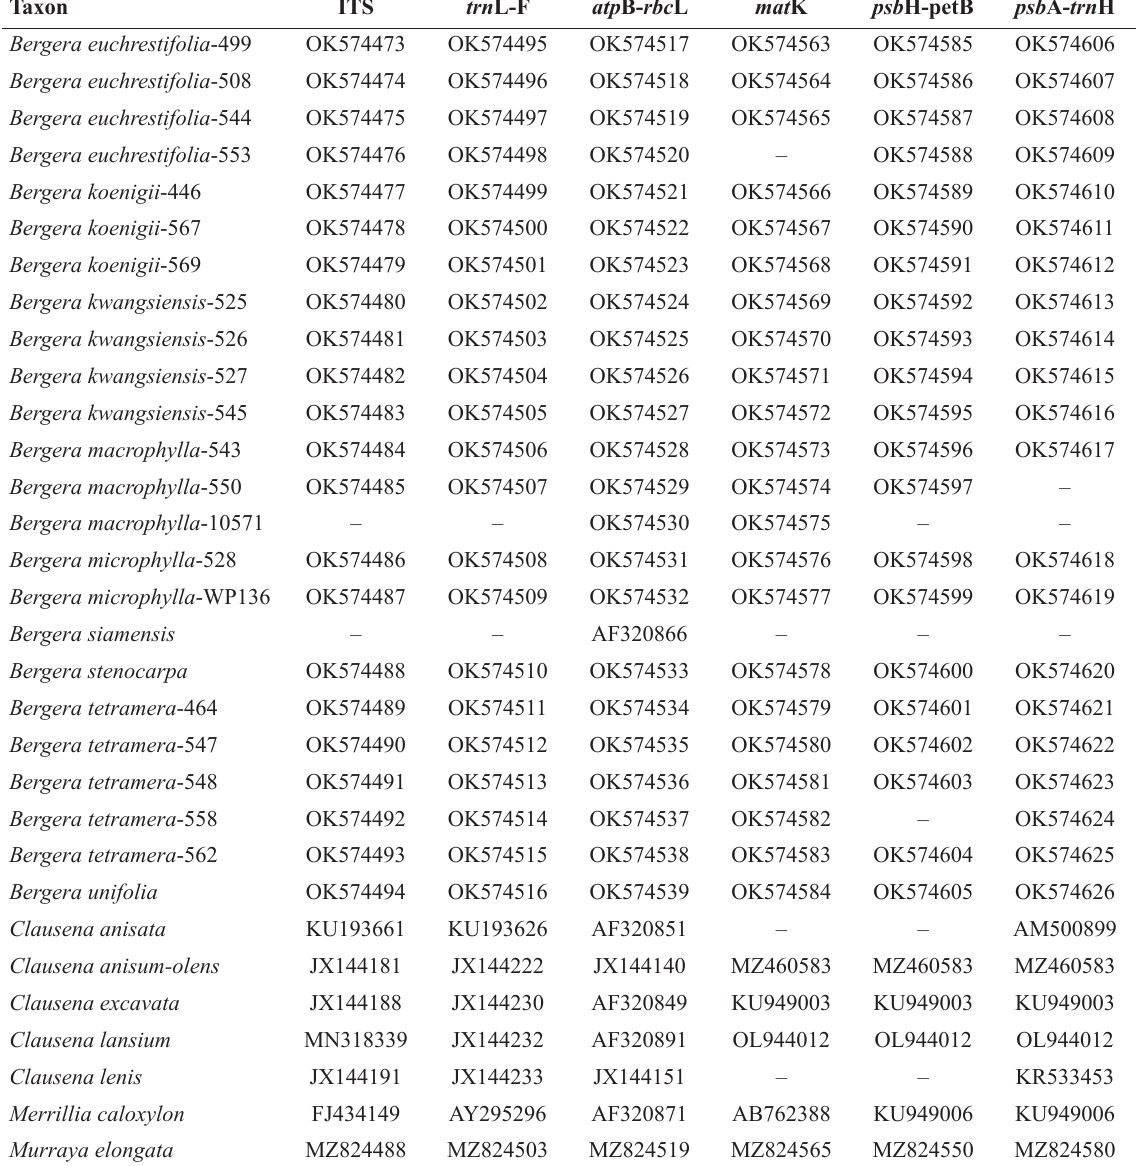
Table 4. GeneBank accession numbers for sequences of species of Bergera J.Koenig ex L. ,